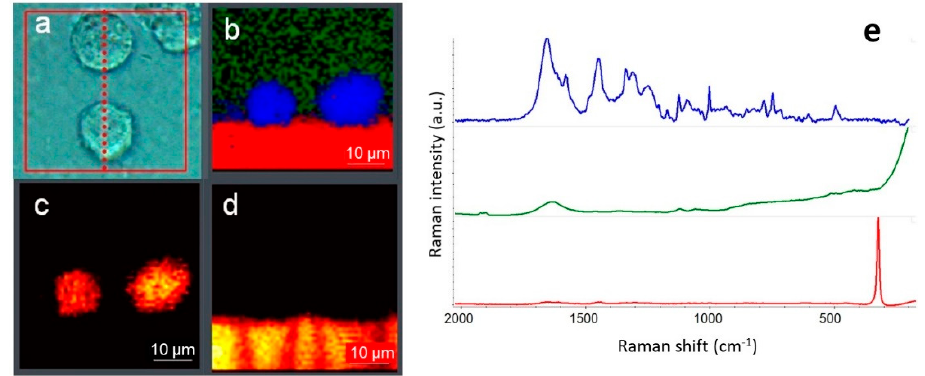
Figure 3. Raman image showing detection of the change in diameter of an individual single-wall carbon nanotube (SWCNT) upon absorbing water: ( a ) the Raman image indicates empty (red) and loaded (blue) parts of SWCNT; ( b ) a micronozzle on a Si substrate used to inject the water; ( c ) the shift of the corresponding radial breathing mode (RBM) peak occurs because the position of the peak is inversely proportional to the diameter of the SWCNT [16,17]. Measurement parameters: 532 nm excitation, 4 mW of the laser power at sample, 100×/0.9 N.A. objective, 50 µm confocal pinhole, 0.4 µm image pixel, 14,000 spectra, 12 min total collect time.